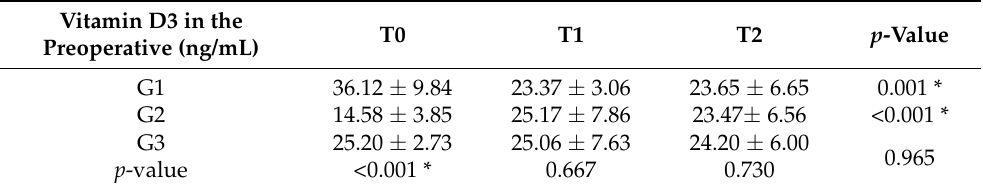
Table 2. Mean serum concentration of vitamin D3 in the assessed times, according to the classification of the nutritional status of vitamin D3 in the preoperative